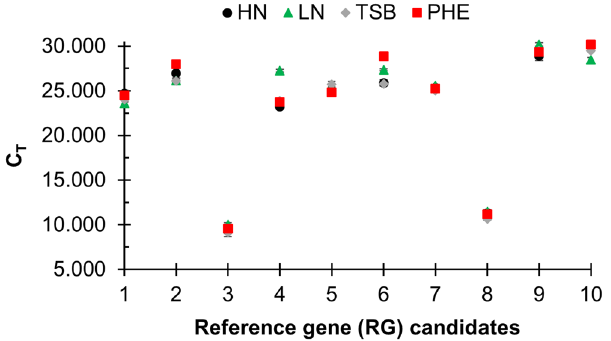
Figure 2. C T values for ten candidate reference genes in R . opacus . RNA was extracted from biological triplicates of R . opacus grown in four distinct growth conditions (HN [circle], LN [triangle], TSB [diamond], and PHE [square]; see Materials and Methods for full description). RT-qPCR was performed in technical triplicate on each biological replicate. Each point represents the average threshold cycle (C T ) value of all replicates for the listed gene and growth condition. Error bars represent one standard